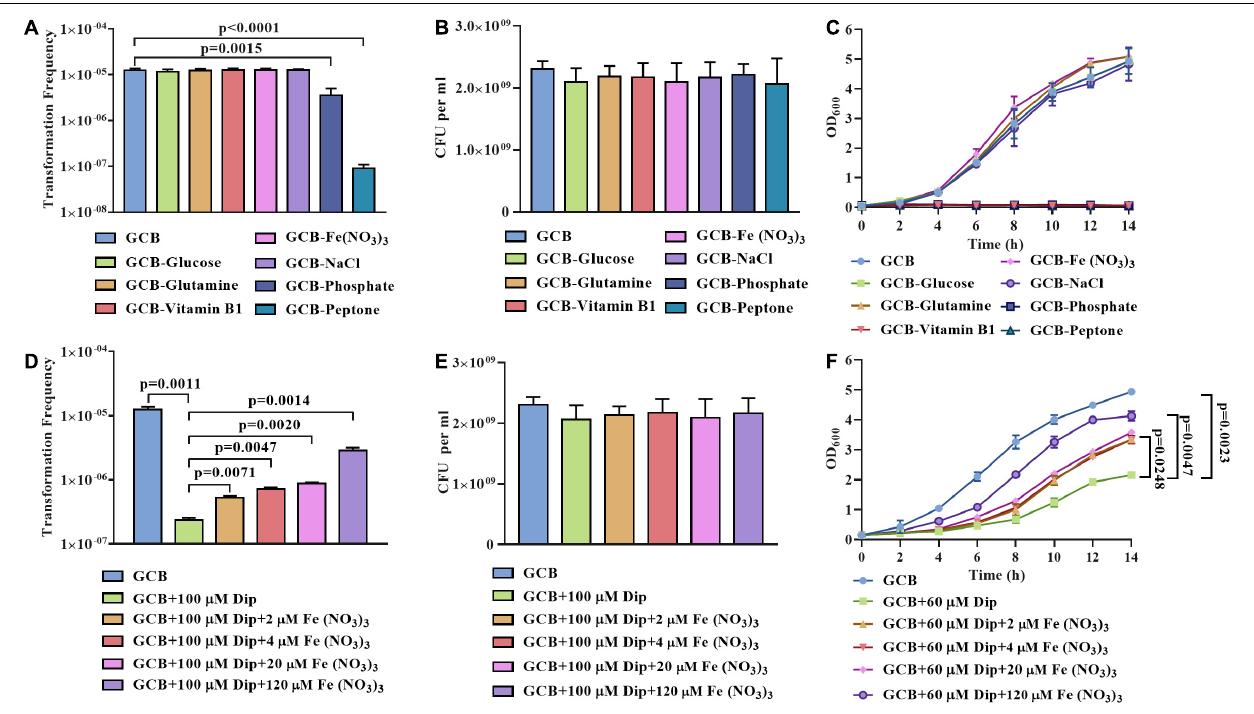
FIGURE 1 | Natural transformation assay of R. anatipestifer ATCC 11845 in nutrient-limited GCB medium. (A) The natural transformation frequency of R. anatipestifer ATCC 11845 in the GCB medium and GCB medium without glucose, L-glutamine, vitamin B1, Fe (NO 3 ) 3 , NaCl, phosphate, and peptone, respectively. The bacteria were grown to the exponential phase in the GCB medium, then, they were resuspended to an OD 600 of 1 in fresh GCB medium and GCB medium without one of the following: glucose, L-glutamine, vitamin B1, Fe (NO 3 ) 3 , NaCl, phosphate (K 2 HPO 4 and KH 2 PO 4 ), and peptone, respectively. Following preincubation at 37 ◦ C for 1 h with shaking, the bacterial suspensions (0.3 ml) were used to perform the natural transformation assay as described in section “Materials and Methods.” (B) The input bacterial titer of ∼ 2.5 × 10 9 CFU were suspended in 1 ml GCB medium and GCB without glucose, L-glutamine, vitamin B1, Fe(NO 3 ) 3 , NaCl, phosphate, and peptone, respectively. After 1 h of incubation at 37 ◦ C, the viability of R. anatipestifer ATCC 11845 was determined. The number of survival bacteria did not change significantly ( p > 0.05). (C) The growth curve of R. anatipestifer ATCC 11845 in the GCB medium and GCB medium without glucose, L-glutamine, vitamin B1, Fe (NO 3 ) 3 , NaCl, phosphate, and peptone, respectively. The bacteria were grown to the exponential phase in the GCB medium, then, they were resuspended in fresh GCB medium and GCB medium without one of the following: glucose, L-glutamine, vitamin B1, Fe (NO 3 ) 3 , NaCl, phosphate (K 2 HPO 4 and KH 2 PO 4 ), and peptone, respectively, to an OD 600 of 0.05. The bacteria were cultured at 37 ◦ C with shaking, and the OD 600 was measured every 2 h for 14 h. (D) The effect of iron on the natural transformation frequency of R. anatipestifer ATCC 11845. The bacteria were grown to the exponential phase in the GCB medium, then, they were resuspended to an OD 600 of 1 in fresh GCB medium, GCB medium containing 100 µ M Dip, and GCB medium containing 100 µ M Dip was supplemented with 2, 4, 20, and 120 µ M Fe(NO 3 ) 3 , respectively. Following preincubation at 37 ◦ C for 1 h with shaking, the bacterial suspensions (0.3 ml) were used to perform the natural transformation assay as described in section “Materials and Methods.” (E) The input bacterial titer of ∼ 2.5 × 109 CFU were suspended in 1 ml of GCB medium, GCB medium containing 100 µ M Dip, GCB medium containing 100 µ M Dip supplemented with 2, 4, 20, and 120 µ M Fe(NO 3 ) 3 , respectively. After 1 h of incubation at 37 ◦ C, the viability of R. anatipestifer ATCC 11845 was determined. The number of survival bacteria did not change significantly ( p > 0.05). (F) The growth curve of R. anatipestifer ATCC 11845 in the GCB medium, GCB medium containing 60 µ M Dip, and GCB containing 60 µ M Dip supplemented with 2, 4, 20, and 120 µ M Fe(NO 3 ) 3 , respectively. The bacteria were grown to the exponential phase in the GCB medium, then, they were resuspended in fresh GCB medium, GCB medium containing 60 µ M Dip, and GCB containing 60 µ M Dip supplemented with 2, 4, 20, and 120 µ M Fe(NO 3 ) 3 , respectively. The bacteria